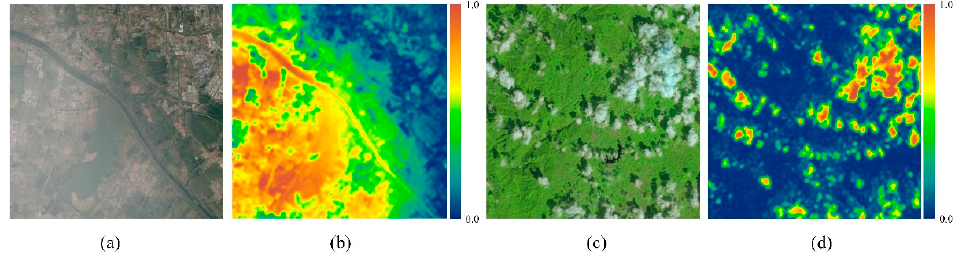
Figure 4. Examples of cloudy images ( x RGB ), and the corresponding distortion coding maps ( m DC ). ( a ) RICE1/ x RGB 1; ( b ) RICE1/ m DC 1; ( c ) RICE2/ x RGB 2; ( d ) RICE2/ m DC 2.